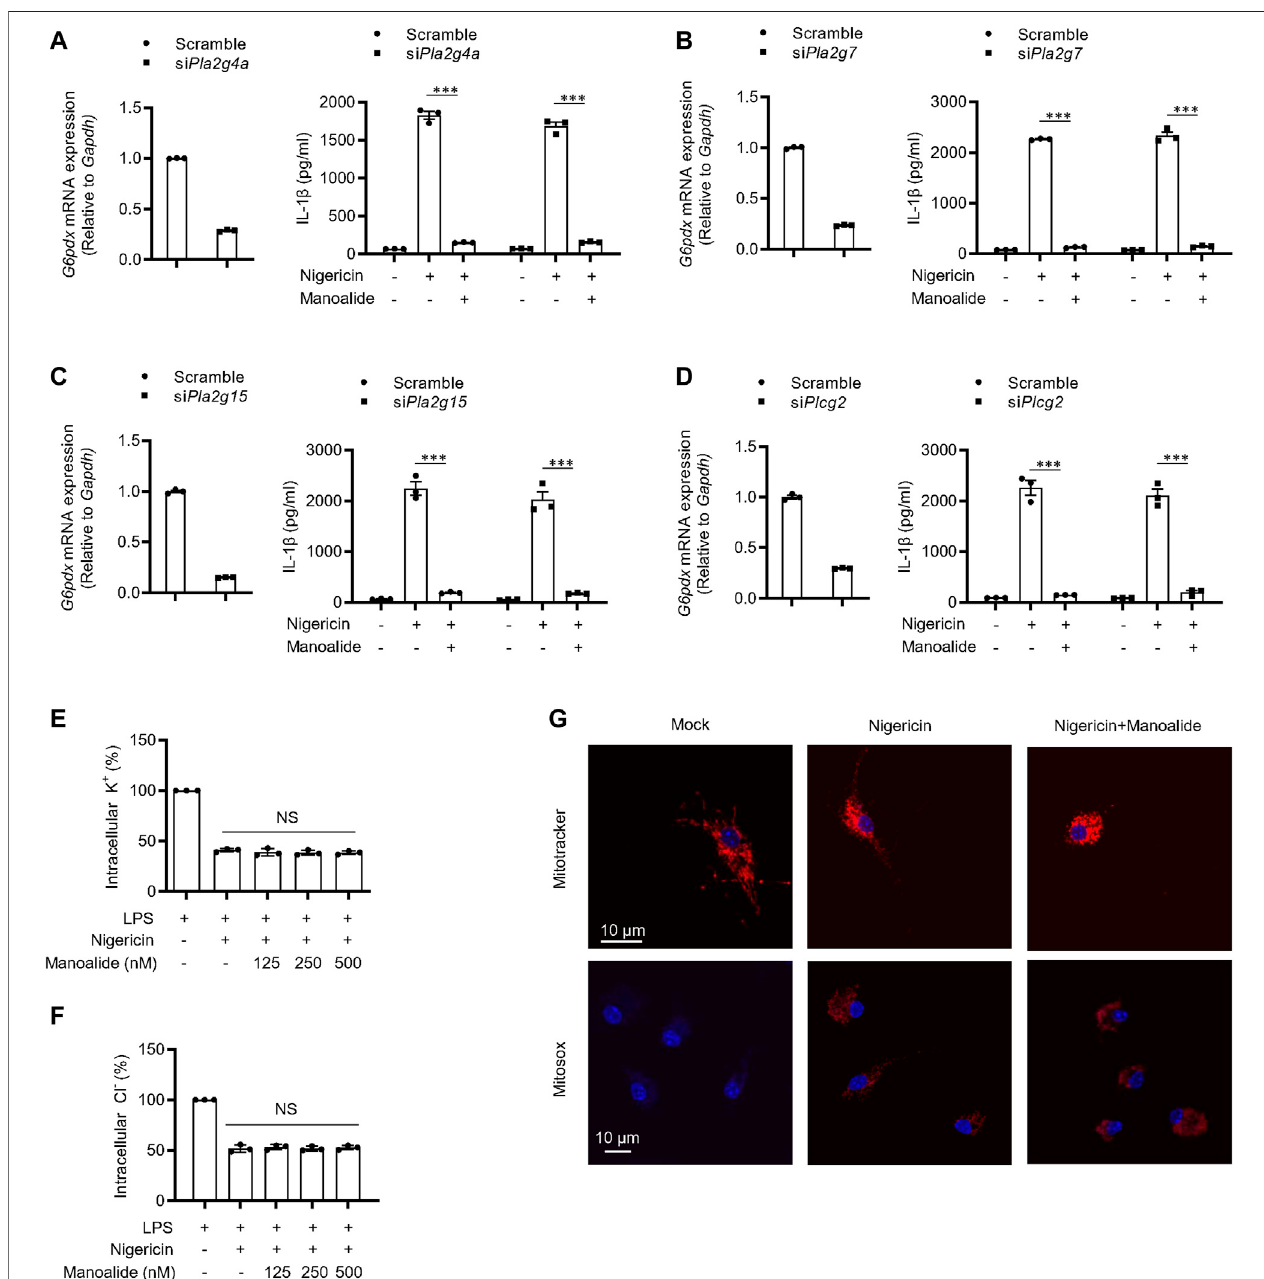
FIGURE3| Manoalide hasnoeffectsonpotassiumef fl ux, chloride ef fl ux ormitochondrial damageand inhibits theNLRP3 in fl ammasomeactivationindependently of PLA2/PLC signaling. (A – D) PLA 2 and PLC expression were knock down by siRNA in BMDMs. Then, the BMDMs were primed with LPS for 3 h and then were pretreated with 500 nM manoalide before stimulation with nigericin for 15 min (A) Pla2g4a, (B) Pla2g7, (C) Pla2g15 and (D) Plcg2 mRNA in BMDMs transfected with siRNA or control siRNA and ELISA of mature IL-1 β in supernatant. Quali fi cation of potassium ef fl ux (E) and chloride ef fl ux (F) in BMDMs primed with LPS and then were pretreated with 125, 250, 500 nM manoalide before stimulation with nigericin. (G) Confocal microscopy analysis of LPS-primed BMDM pretreated with 500 nM manoalide before stimulation with nigericin, then stained with MitoSOX red, Mitotracker red and DAPI. Data are derived from three independent experiments (A – F) and displayed as mean and SEM ( n = 3) or represent three independent experiments (G) . Statistically signi fi cant difference was calculated by unpaired Student ’ s t-test: NS, not signi fi cant.